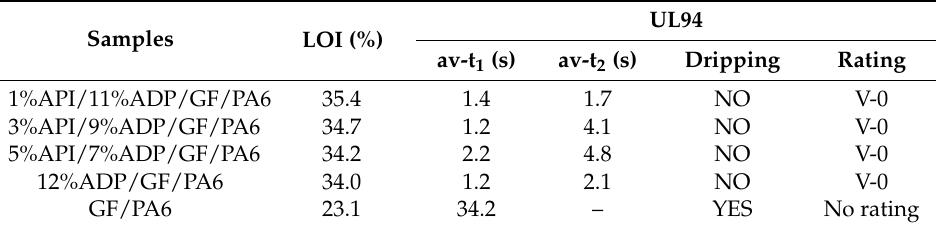
Table 3. LOI value and UL94 rating of PA6 composites.